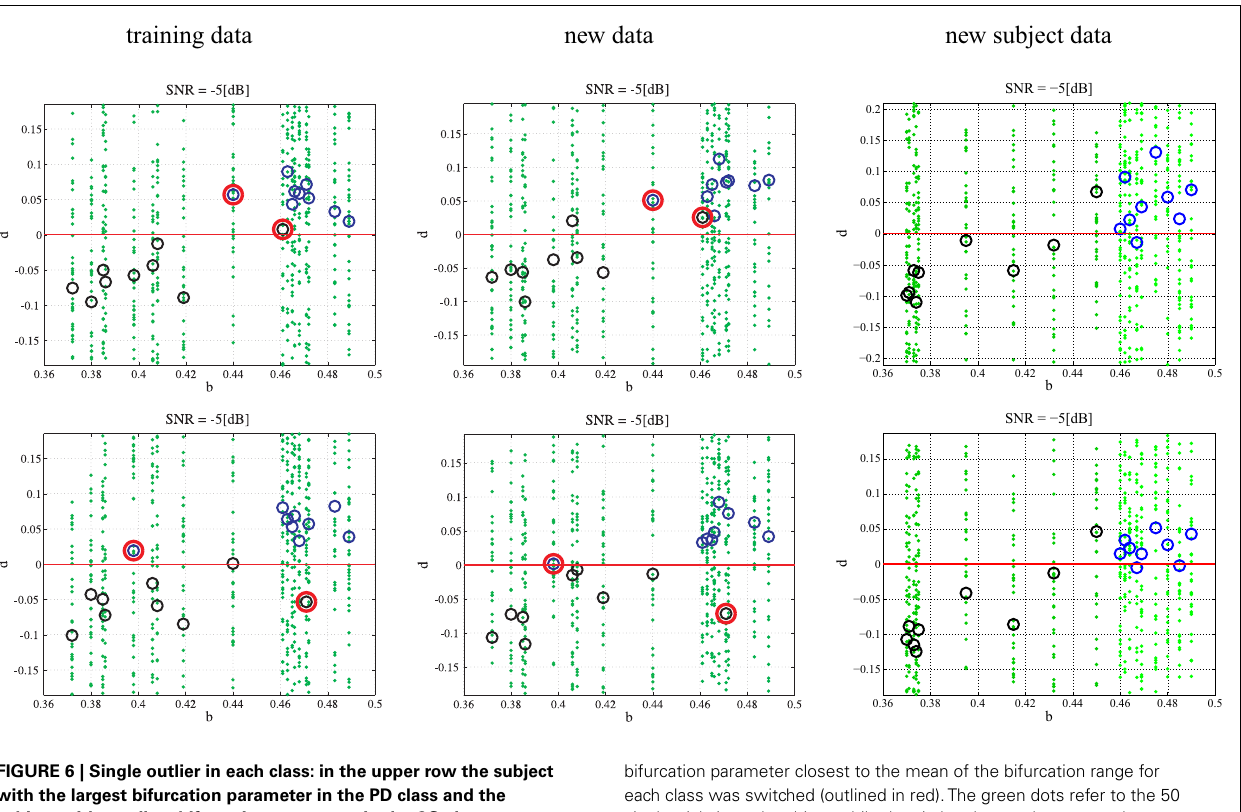
FIGURE 6 | Single outlier in each class: in the upper row the subject with the largest bifurcation parameter in the PD class and the subject with smallest bifurcation parameter in the CO class were switched (outlined in red) . In the lower row the subject with a